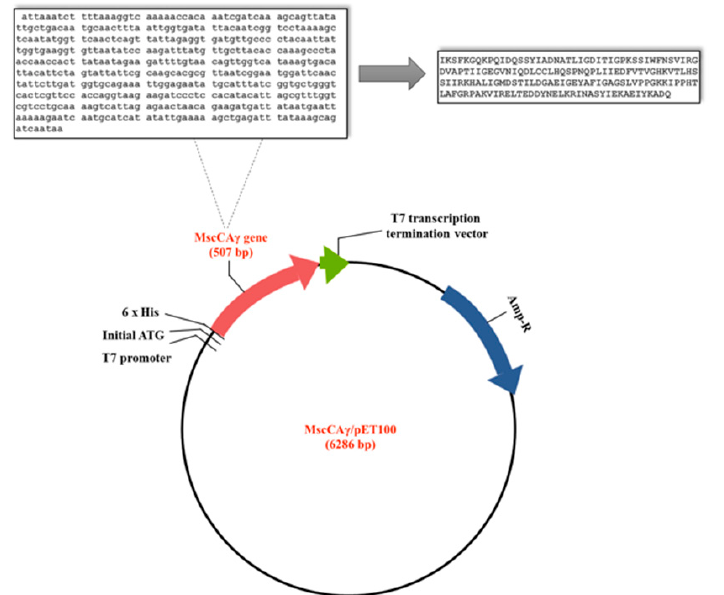
Figure 3. Schematic representation of the obtained construct for overexpressing the recombinant MscCA γ . The cloned nucleotide sequence ( left ) and the encoded amino acid sequence ( right ) are